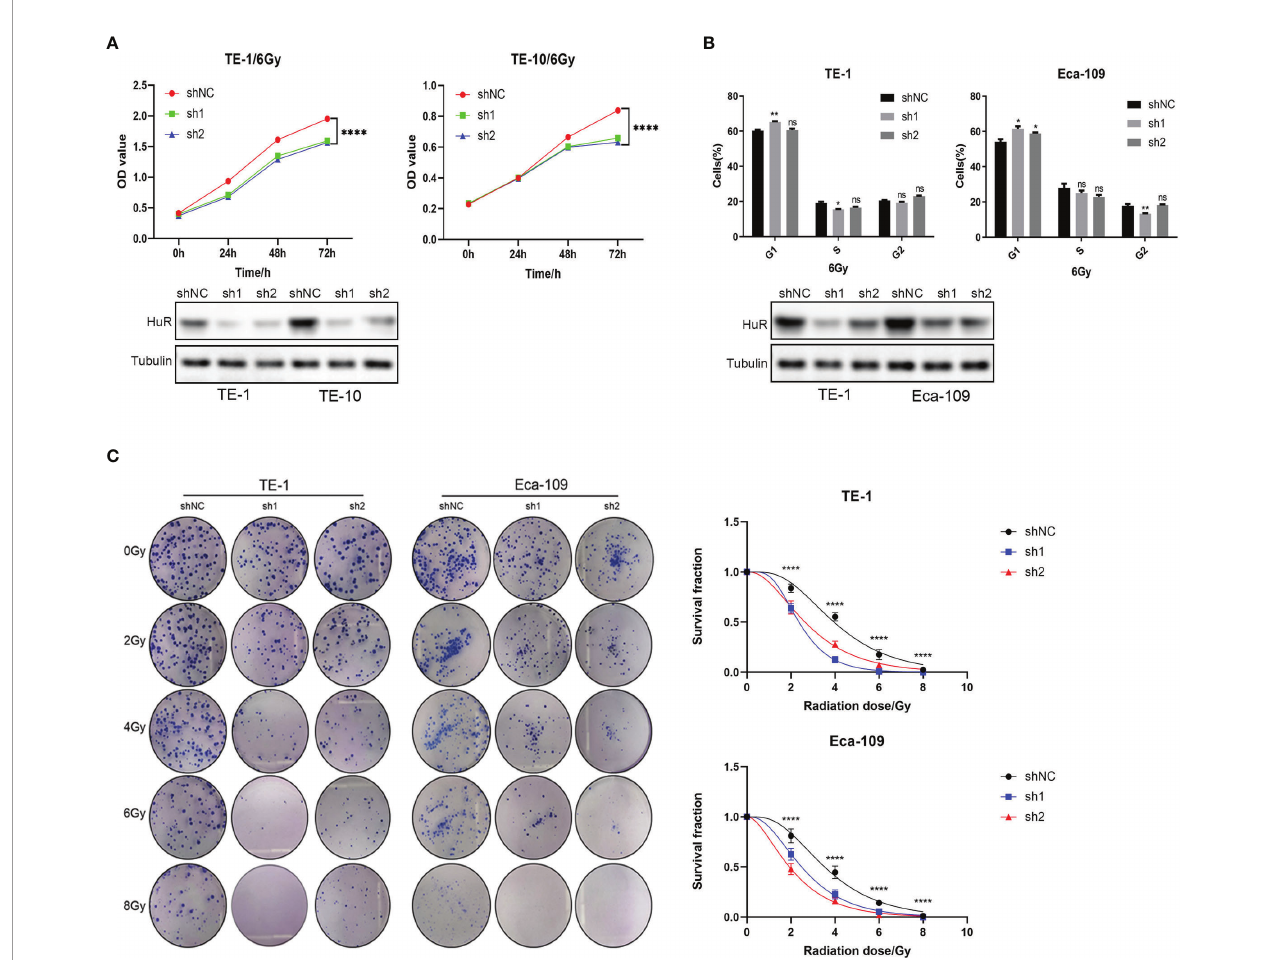
FIGURE 1 | HuR was involved in the effect of X-ray on the proliferation of esophageal cancer cells. (A) CCK8 is used to detect the proliferation of esophageal cancer cells combined with X-ray after HuR downregulation. HuR downregulation inhibits the proliferation of esophageal cancer cells. (B) HuR downregulation increases the proportion of cells in G1. (C) The effect of HuR on the colony formation rate of esophageal cancer cells is veri fi ed by the colony formation test. The bar graph shows the colony formation rates. HuR downregulation decreases the colony formation of esophageal cancer cells. ns >0.05, *p < 0.05, **p < 0.01 and ****p <